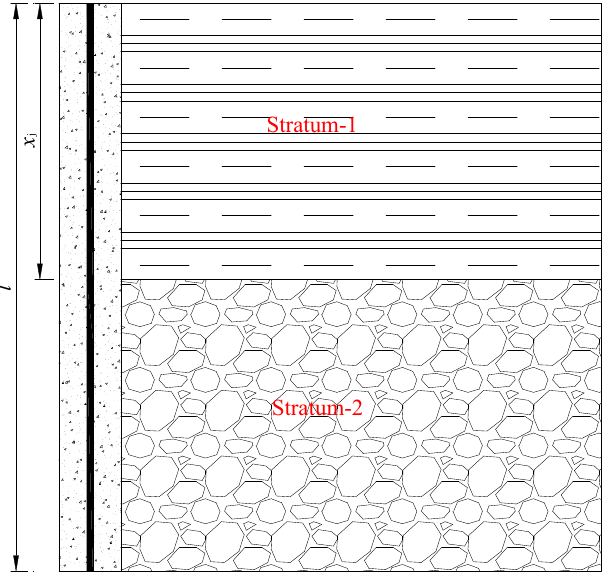
Figure 4. Ground anchors buried in upper and lower parallel strata foundation.